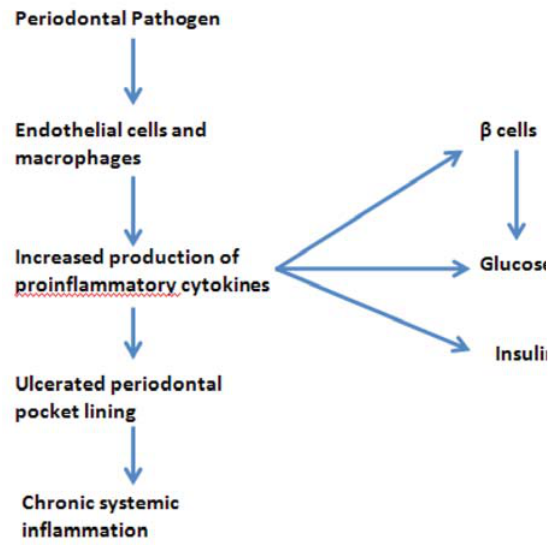
Figure 1. Model for periodontal infection contributing to systemic in fl ammation and complicating DM.